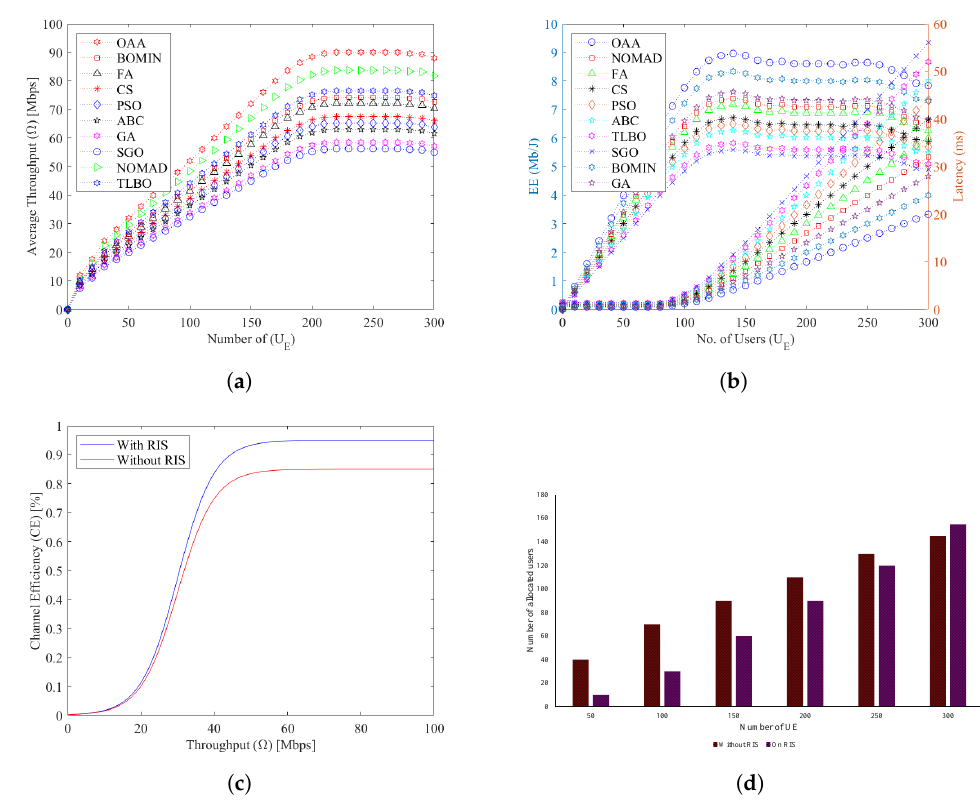
Figure 5. Performance analysis of the proposed algorithm. ( a ) Average Ω (Mbps) vs. No. of U E ; ( b ) No. of U E vs. EE and Latency (ms); ( c ) Channel efficiency ( CE ) vs. Ω ; ( d ) Resource allocation to U E